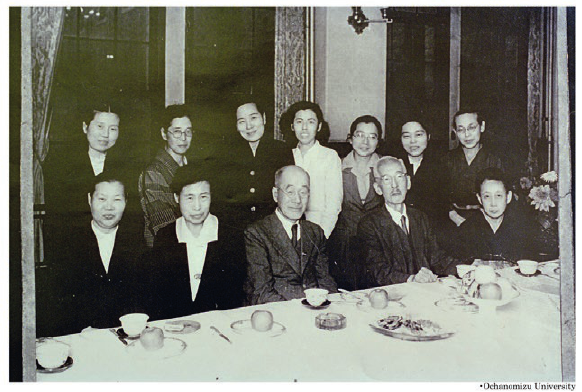
Figure 9. (Ku-6033), Prof. Majima, Surrounding Prof. Katayama 片 山先生 Showa 26 October 1951. Front row from left ：辻村みちよ Tsujimura Michiyo, 黒田チカ Kuroda Chika (67 years old), 眞島利 行先生 Prof. Majima Riko, 片山正夫 Katayama Masao, 片山正夫 夫人 Mrs. Katayama Masao. Back row from right: 伊達たまき Date Tamaki, 山西貞 Yamanishi Tei, 岡嶋正枝 Okajima Masae, 鈴木照 子 Suzuki Teruko, 吉田武子 Yoshida Takeko, 一人おいて leaving out one person, 小林ハナ子 Kobayashi